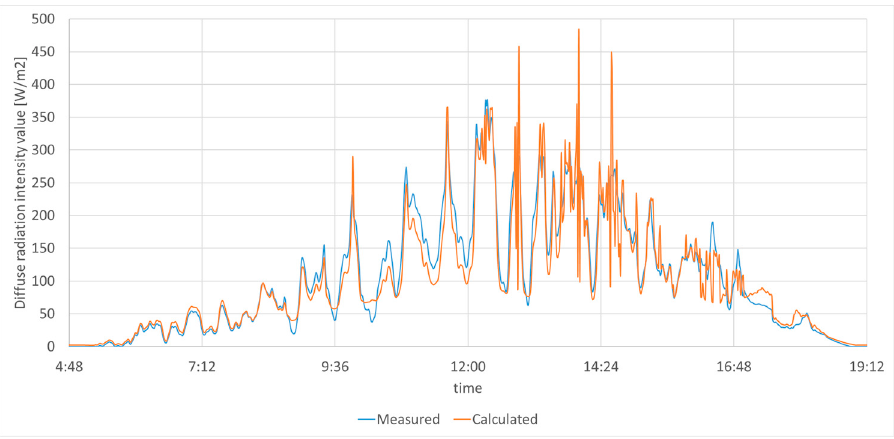
Figure 16. Compared scattered irradiance values measured and calculated using bivariate 5th-order polynomial.